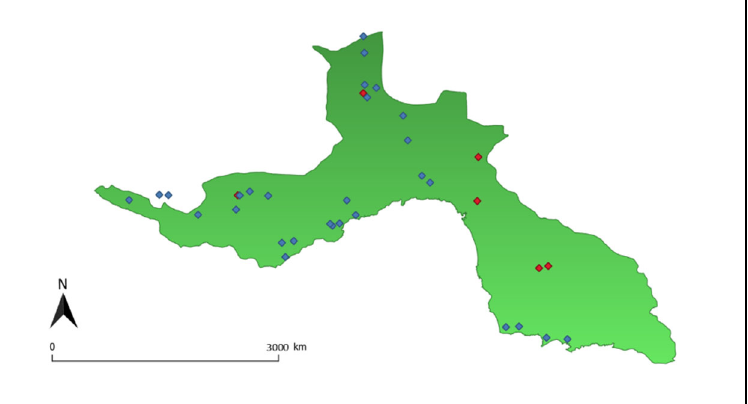
Figure 6. The location of prospect solar and wind projects; red: wind projects; blue: solar projects. In this context, in order to respond to increase of demand in 2030, seven energy plans have been defined. Figure 7 presents the defined energy plans in a diagram. The potential, position, and indicators mentioned are taken into consideration for each of the